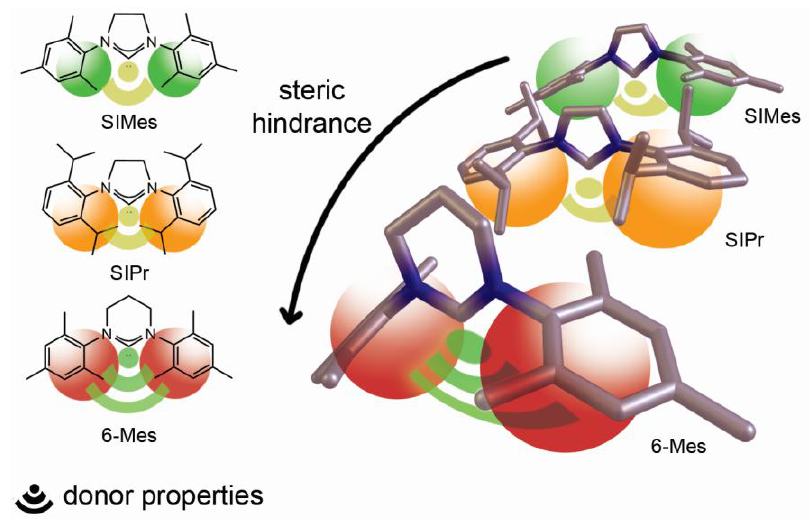
Figure 1. Relationship between steric and electronic properties of 6-Mes and SIMes/SIPr —previously used for the synthesis of Me 2 MOR(NHC) (M = Ga, In) complexes [1–3].